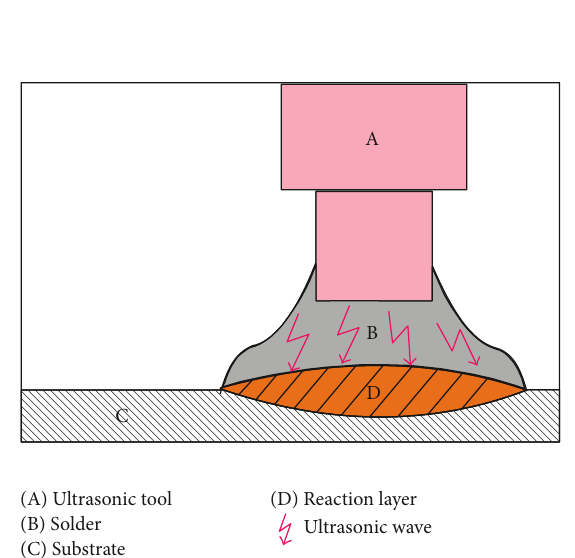
Figure 2: Ultrasonic soldering through the layer of molten